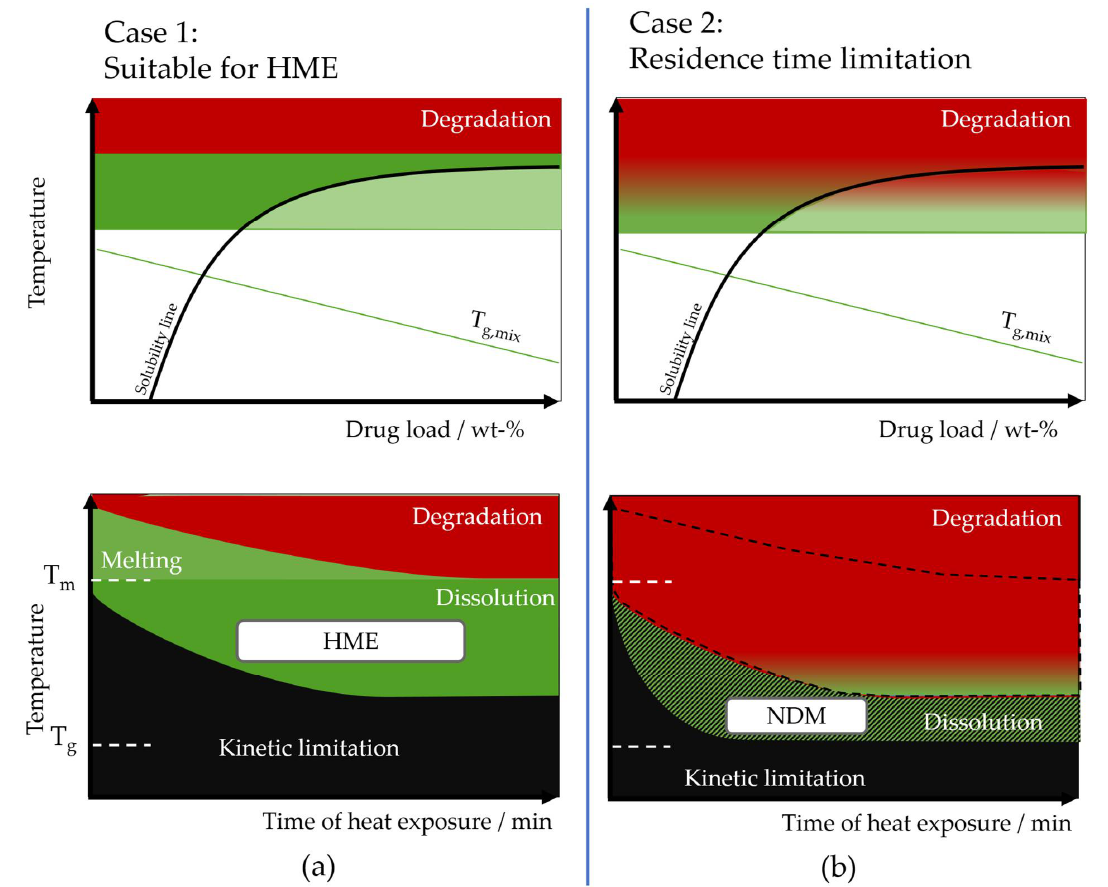
Figure 13. Principal schematic of the different thermodynamic (upper pictures) and kinetic (lower pictures) situation during ASD processing. ( a ) Case 1 with a suitable design space that allows Hot Melt Extrusion (HME) processing. ( b ) Case 2 with the phase diagram of a thermosensitive system. Early degradation kinetically limits HME processing. The available design space in case 1, marked by the black dashed line is red in case 2 because of degradation. Nano-Dry-Melting (NDM) is capable of opening further design space due to the short heat exposure times required. Depicted in green is the available design space, the green, black hatched area is showing the additional design space available through NDM. In the red area degradation occurs, the black area is unavailable for processing due to kinetic limitations.